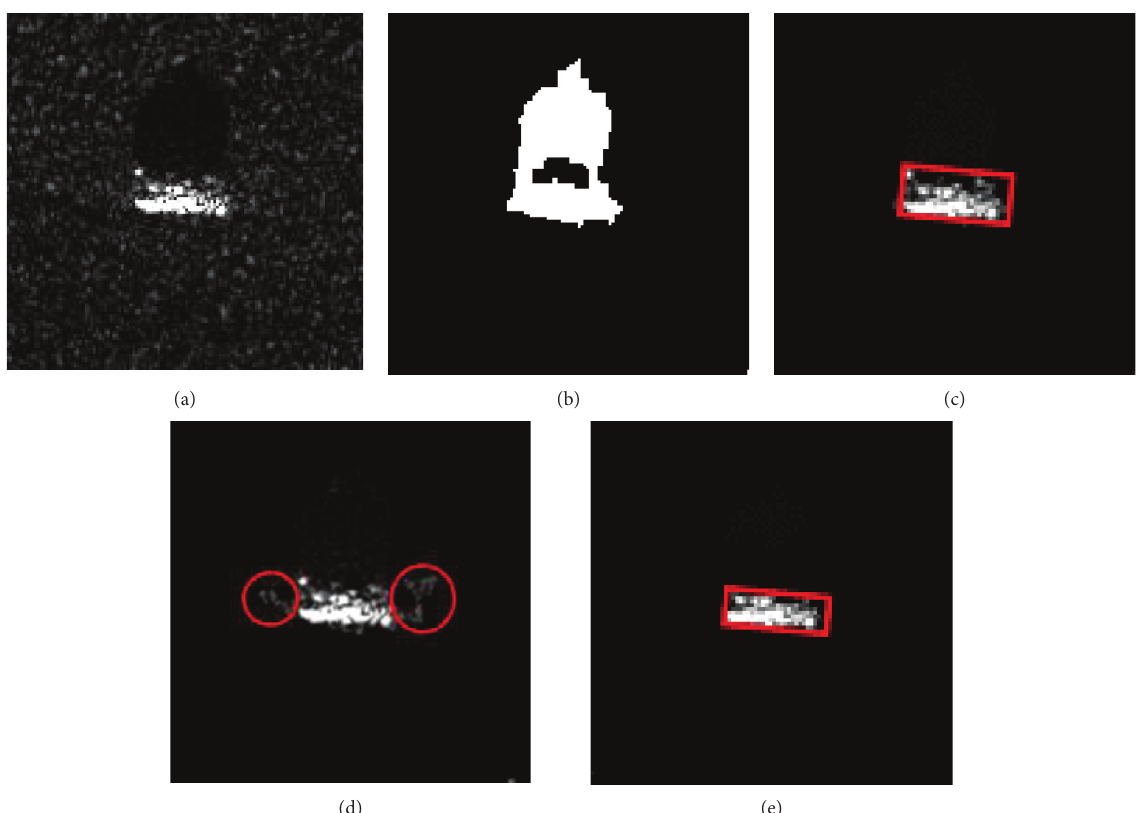
Figure 2: The segmentation of the target and shadow. (a) The original image. (b) Morphological image of target and shadow. (c) Target and shadow when setting the thresholds 0.2 and 0.8. (d) Target and shadow when setting the thresholds 0.1 and 0.8. (e) Target and shadow when setting the thresholds 0.3 and 0.7.